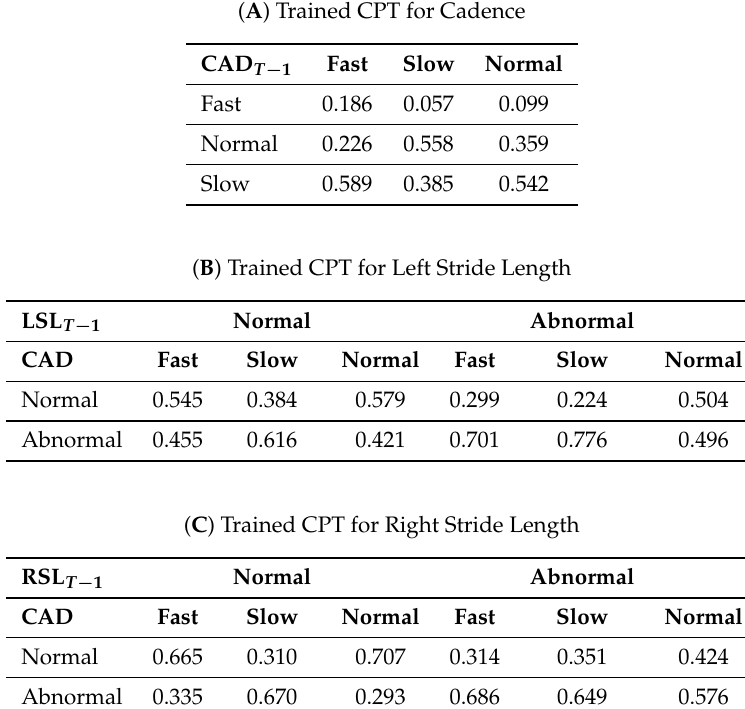
Table 6. Trained conditional probability